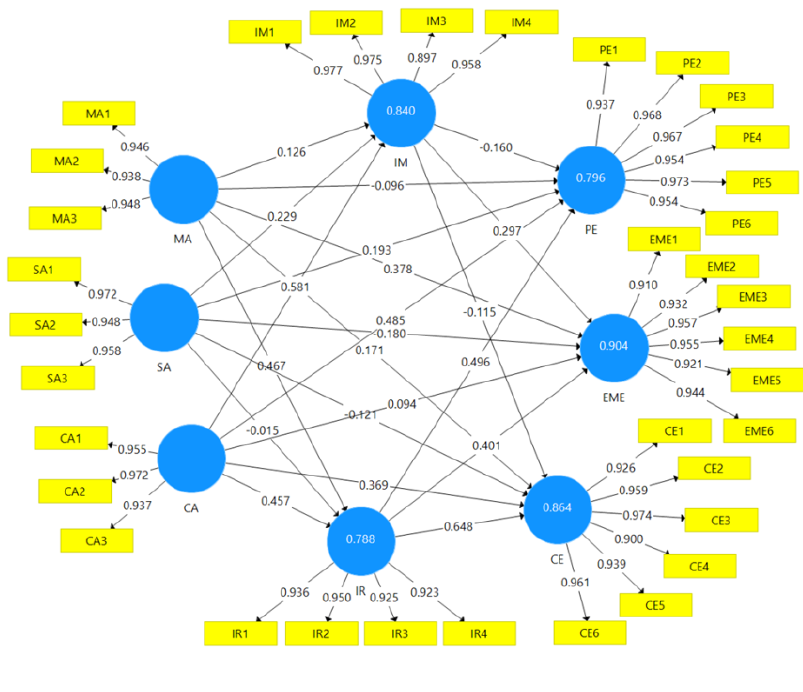
Figure 2: Results of proposed